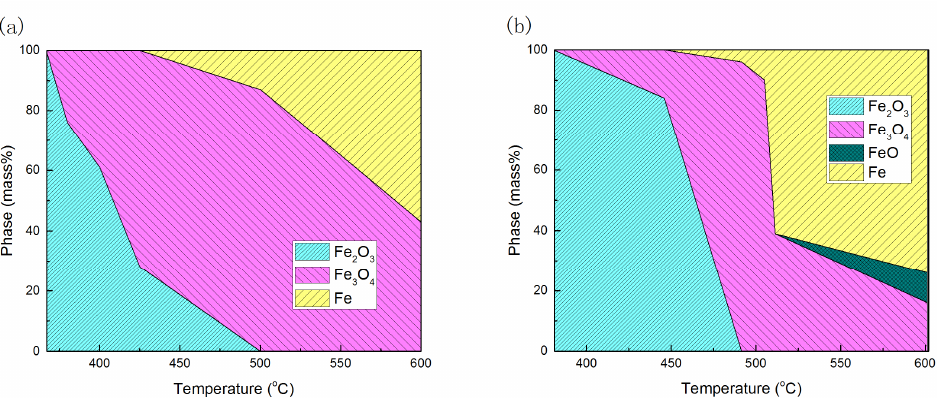
Figure 2. Calculated mass ratio of phases from XRD data by Chung’s model [25,26] in samples reduced partially with pure hydrogen at heating rates of ( a ) 10 and ( b ) 20 °C/min.